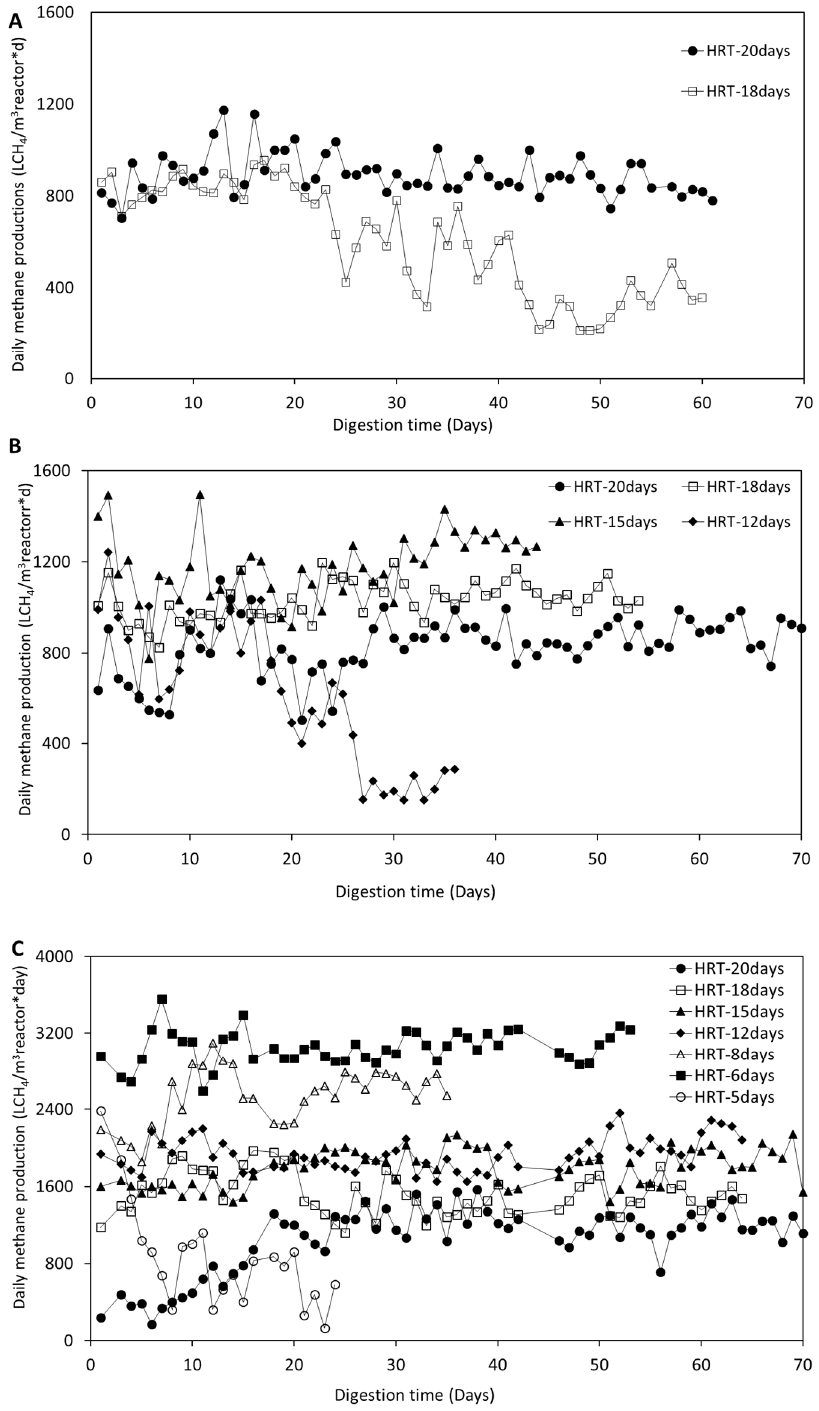
Figure 1. Daily methane productions (production rates as LCH 4 /m 3 reactor * day) in the three SSTR digesters at di ff erent hydraulic retention times. ( A ) SBB, ( B ) SBB + CM, and ( C ) SBB + PM.